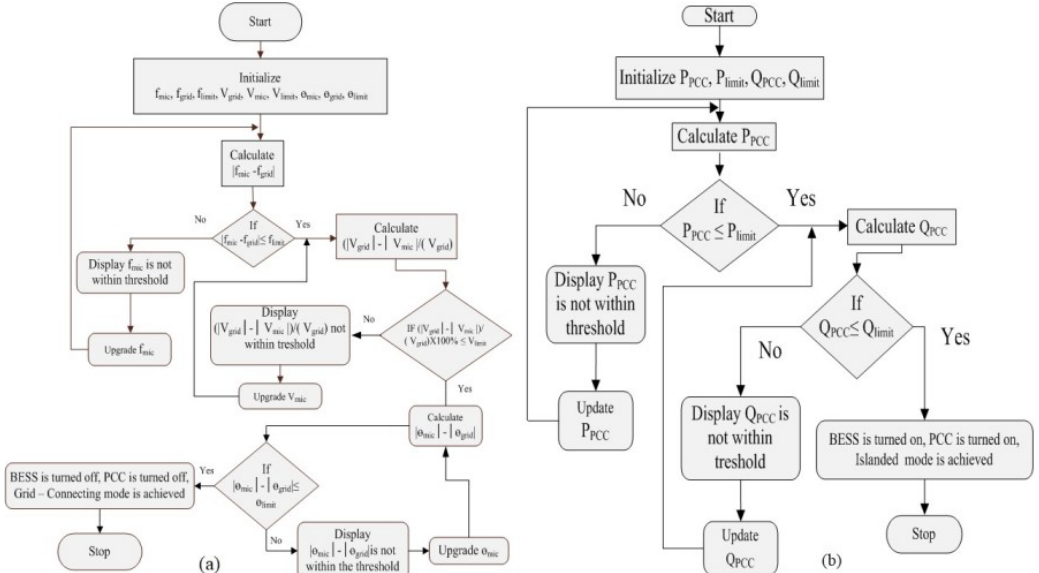
Fig. 5. Flow-chart representing (a) Transition from islanded mode to Grid-connected mode (b) Transition from Grid-connected to islanded